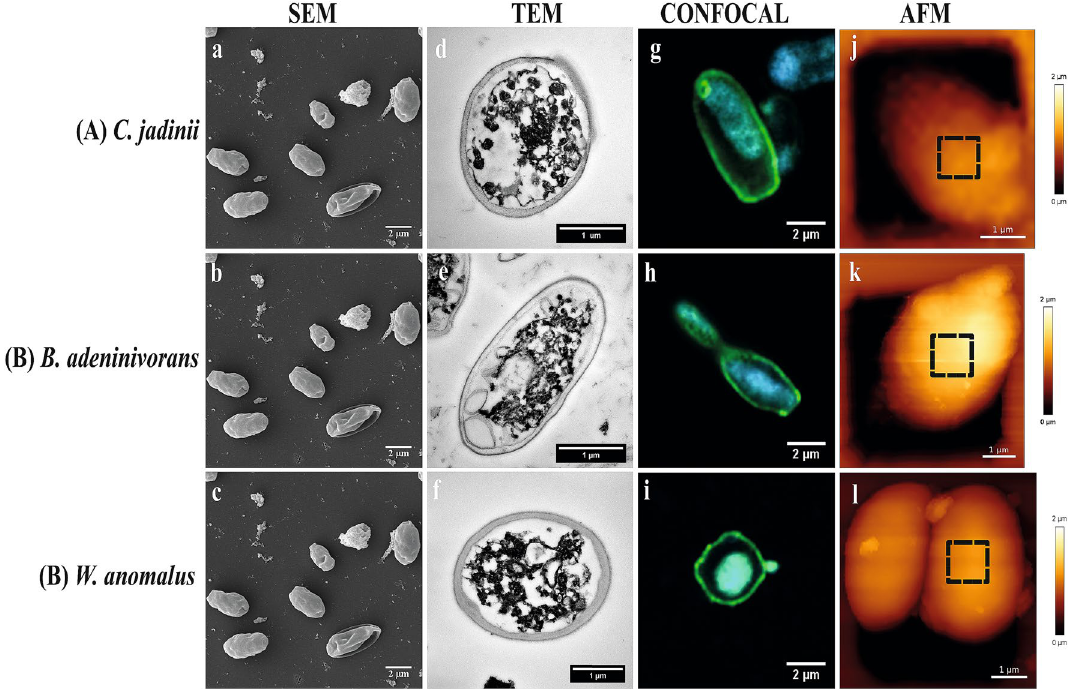
Figure 4. Cell surface architecture of three autolyzed yeast species (50 °C for 16 h) grown on sugars from lignocellulosic biomass. The pictures show Scanning Electron Microscopy ( SEM ; a – c ), Transmission Electron Microscopy ( TEM ; d – f ), Confocal microscopy (stained with concanavalin A-FITC for mannan) ( g – i ) and Atomic Force Microscopy ( AFM ; height) ( j – l ) micrographs of Cyberlindnera jadinii ( panel A ), Blastobotrys adeninivorans ( panel B ) and Wickerhamomyces anomalus ( panel C ). The SEM and TEM micrographs were taken on yeast creams (before drying), whereas the confocal and AFM micrographs were taken on dried yeast samples, as described in the ‘Material and Methods’. The dotted squares on the AFM height micrographs represent the spots where mapping was done for determination of the Young modulus and measurement of adhesion events, as described in ‘Material and